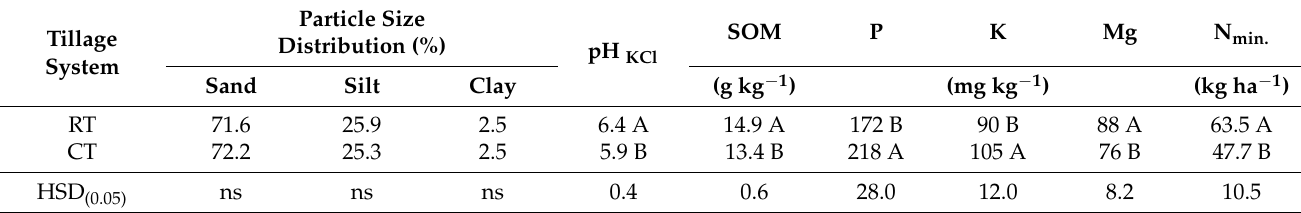
Table 1. Basic soil characteristics at 0–20 cm depth under different tillage systems for years